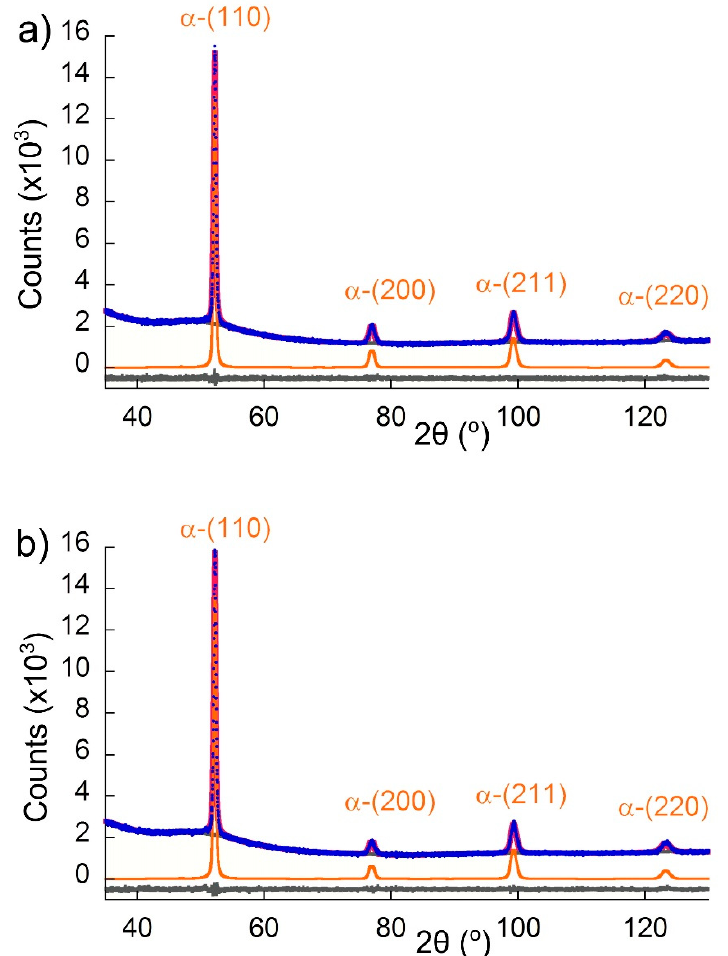
Figure 8. X-ray di ff raction patterns of the samples after tempering for: ( a ) 15 and ( b ) 60 min Figure 8. X-ray diffraction patterns of the samples after tempering for: ( a ) 15 and ( b ) 60 min (blue (blue line—experimental pattern, red line—calculated pattern, gray line—di ff erential line—experimental pattern, red line—calculated pattern, gray line—differential curve).